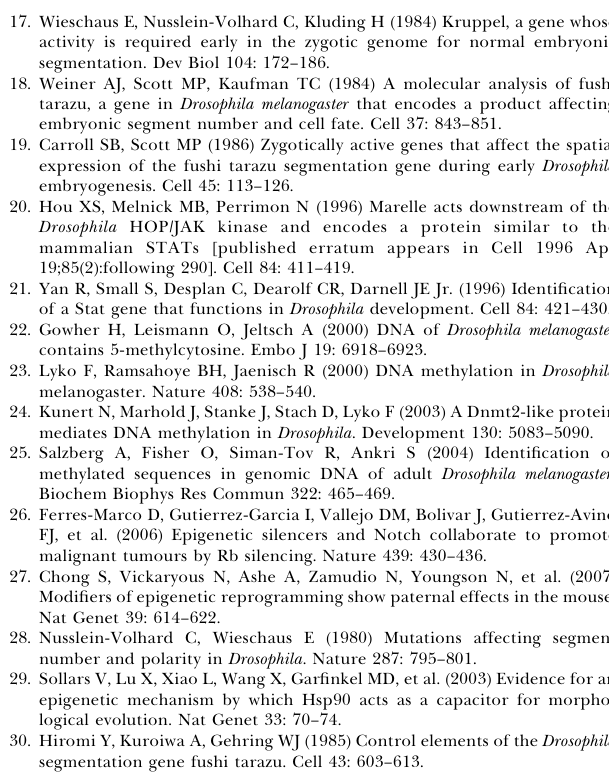
Figure S1. Full-Length Western Gel Images for Figure 1E Found at doi:10.1371/journal.pgen.0030151.sg001 (1.5 MB JPG). Figure S2. The ftz Minimal Enhancer Partial sequence of the ftz-lacZ transgene is shown. PCR primers used in amplification of the genomic fragment are indicated in green and purple. Numbers correspond to nucleotide position of the PCR fragment. Two CG or CT-rich sequences are boxed in red. Found at doi:10.1371/journal.pgen.0030151.sg002 (1.6 MB JPG). Table S1. Accession Numbers for Mutations Used in This